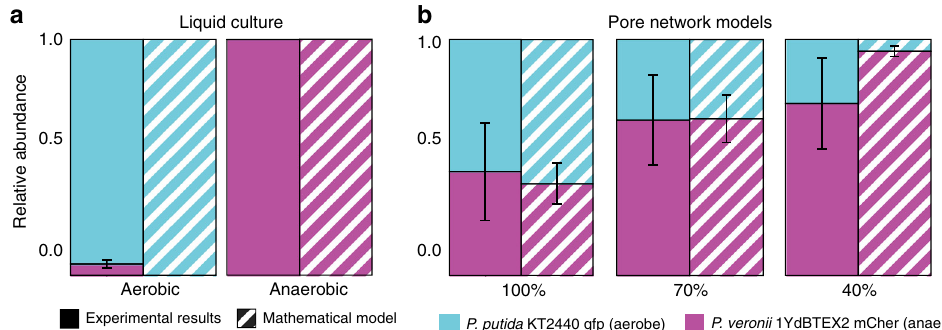
Fig. 5 Relative abundance of the two species in the community as a function of growth conditions and spatial structure of the environment. a Aerobes and facultative anaerobes were cocultured in shaken liquid medium to create an unstructured environment. A 1:1 ratio of aerobes to anaerobes was used to inoculate sealed serum fl asks (to promote anaerobic respiration) or test tubes (aerobic respiration). After 72 h of incubation, culture samples were plated on selective agar media to determine the ratio of aerobes and anaerobes. Error bars show one standard deviation around the mean calculated from ten replicate cultures. Simulations represented a fully oxic and fully anoxic environment for the aerobic and anaerobic conditions, respectively. b Relative abundance of aerobes and anaerobes in pore networks calculated from results presented in Fig. 4a – c using counter-gradients (central carbon and peripheral oxygen). Error bars represent one standard deviation around the mean calculated from eight model realizations for mathematical results and three, four and fi ve replicates for the experimental results in the 100%, 70% and 40% connectivity, respectively. In well-mixed environments represented as liquid fl asks, very limited coexistence (aerobic conditions) or absence of coexistence (anaerobic conditions) were observed with dominance of obligate aerobes in the aerobic case and vice versa for the anaerobic case ( a ). Coexistence was facilitated due to the structured environment and resulting